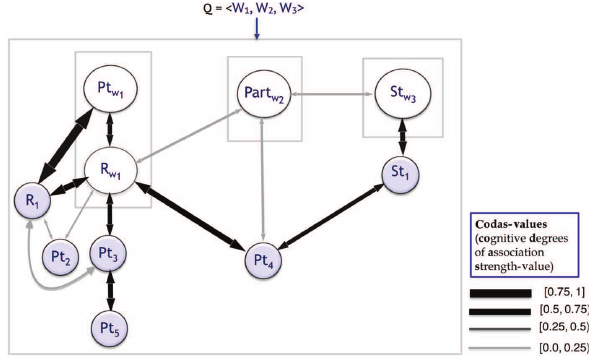
Figure 5: A Joint Local Associative Subnetwork for a Query Consisting of Three Words: Q = ⟨ W 1 , W 2 , W 3 ⟩